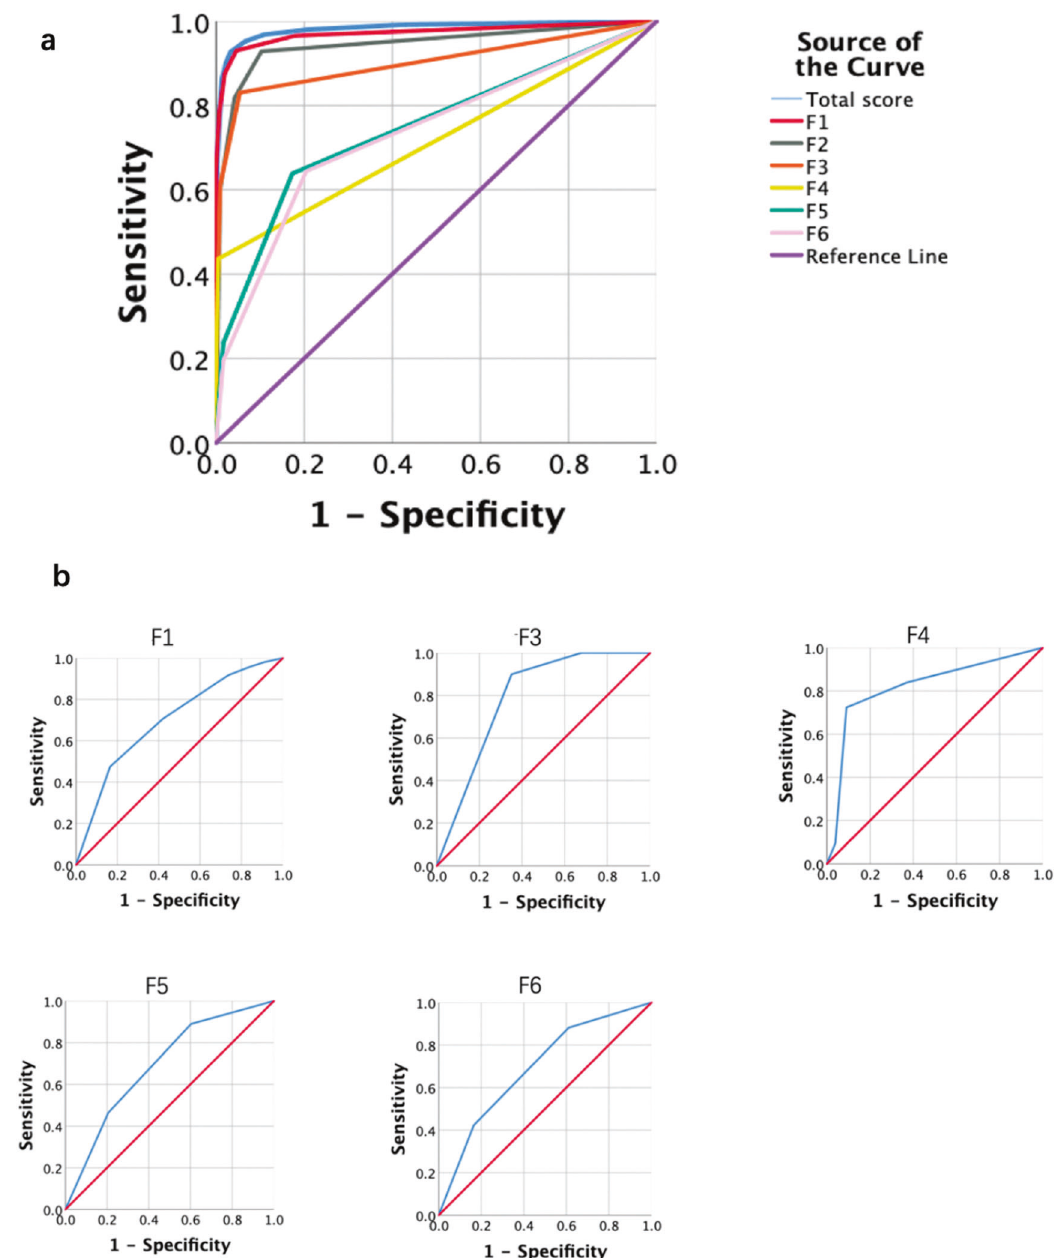
Fig. 1 ROC analysis. a ROC curves of FSQ-MIS total score and factor scores for discriminate patients and healthy controls. Total score for discrimination, AUC = 0.983 ± 0.002, p < 0.001, 95%CI [0.980, 0.986]. F1 for discrimination, AUC = 0.972 ± 0.002, p < 0.001, 95%CI [0.968, 0.977]. F2 for discrimination, AUC = 0.944 ± 0.004, p < 0.001, 95%CI [0.937, 0.952]. F3 for discrimination, AUC = 0.902 ± 0.004, p < 0.001, 95%CI [0.893, 0.911]. F4 for discrimination, AUC = 0.716 ± 0.007, p < 0.001, 95%CI [0.702, 0.731]. F5 for discrimination, AUC = 0.748 ± 0.008, p < 0.001, 95%CI [0.733, 0.763]. F6 for discrimination, AUC = 0.734 ± 0.008, p < 0.001, 95%CI [0.719, 0.750]. b ROC curves for measuring the performance of FSQ- MIS-Factors (F1, F3, F4, F5, F6) in identifying the mental disorders. F1 predicts anxiety and depression related diagnosis, AUC = 0.700 ± 0.010, p < 0.001, 95%CI [0.681, 0.720]; F3 predicts sleep disturbance related diagnosis, AUC = 0.791 ± 0.007, p < 0.001, 95%CI [0.777, 0.806]; F4 predicts psychosis related diagnosis, AUC = 0.820 ± 0.011, p < 0.001, 95%CI [0.799, 0.842]; F5 predicts obsessive-compulsive related diagnosis, AUC = 0.692 ± 0.012, p < 0.001, 95%CI [0.667, 0.716]; F6 predicts excitation symptom related diagnosis, AUC = 0.692 ± 0.013, p < 0.001, 95%CI [0.667, plotted the ROC curves of F1, 3, 4, 5, 6 in predicting anxiety and quanti fi cation. The FSQ-MIS total score and each factor score were depression-related diagnosis (e.g., anxiety, depression, anxiety/ used for discrimination. As shown in Fig. 1a, the AUC ranges from depressive state), sleep disturbance related diagnosis (e.g., 0.716 to 0.983, indicating satisfactory discrimination validity in insomnia, narcolepsy), psychosis related diagnosis (e.g., brief distinguishing patients from healthy individuals. psychotic disorder, delusion disorder, schizophrenia), obsessive- As shown in Fig. 1b, to further evaluate the diagnostic validity of compulsive related diagnosis (e.g., obsessive-compulsive disorder, FSQ-MIS in screening different mental illness symptoms, we